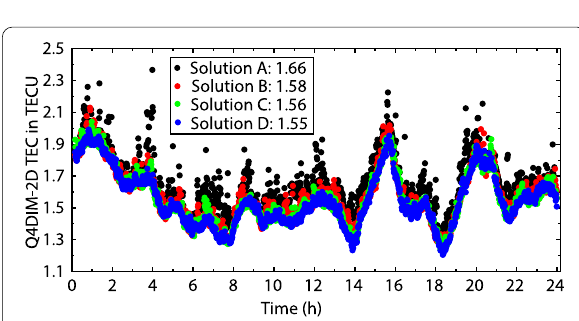
Fig. 4 Series of σ i in Eq. (9) for Q4DIM‑2D TEC map of solution A (black) 12 × 8 , solution B (red) 24 × 16 , solution C (green) 36 ×